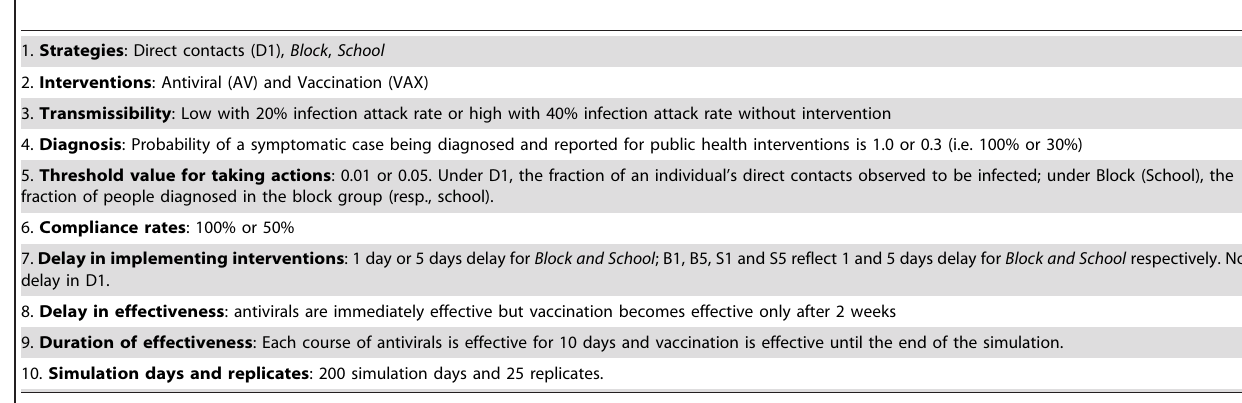
Table 1. Parameter choices.